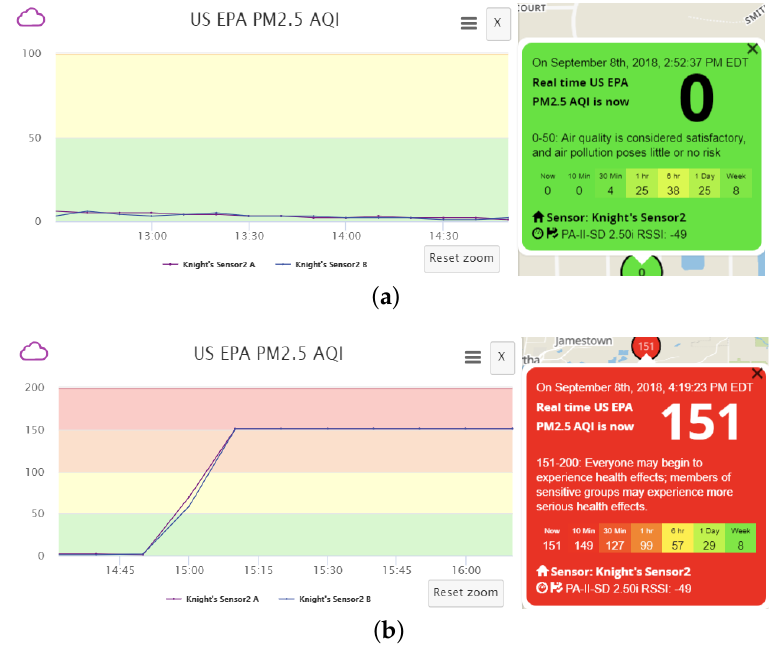
Figure 7. AQI fluctuation for Scenario A. ( a ) Before data pollution; ( b ) After data pollution.